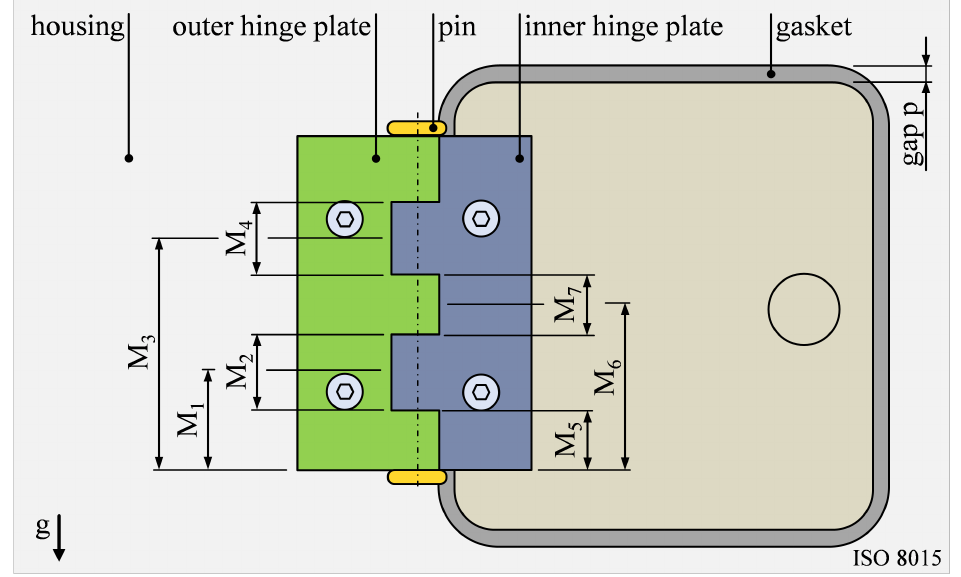
Figure 2. Overconstraint door hinge